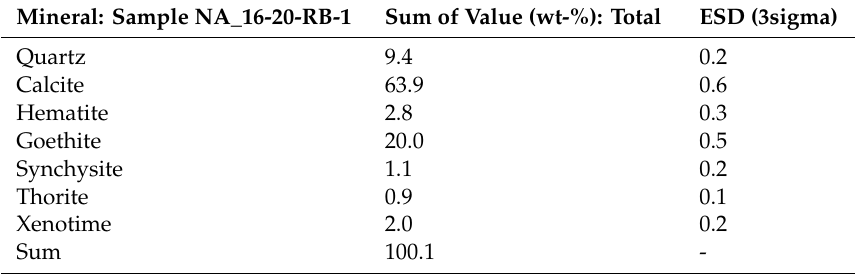
Table 4. XRD results of field sample taken from D1 at validation point 1 shown in Figure 12A.